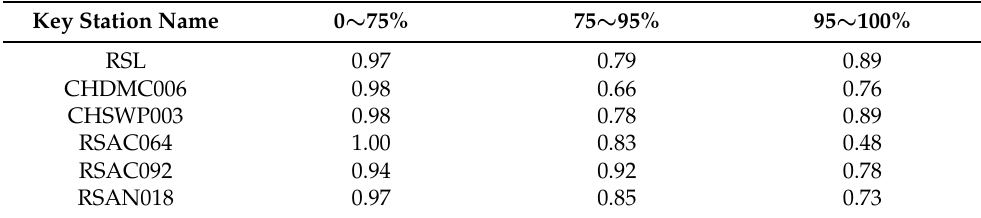
Table A4. Values of MSE ( ∑ T normalized according to Equation (2).